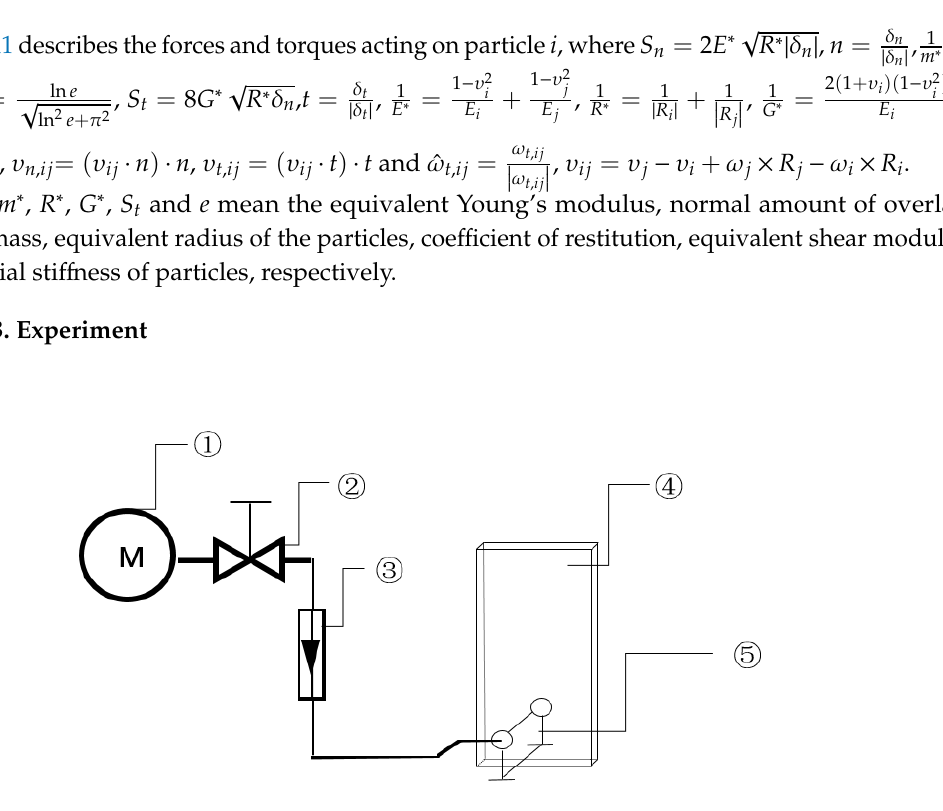
Figure A1. Schematic diagram of the cold physical model. ① —Air compressor; ② —Valve; ③ — Rotor flow meter; ④ —Cold model; ⑤ —Data acquisition system.